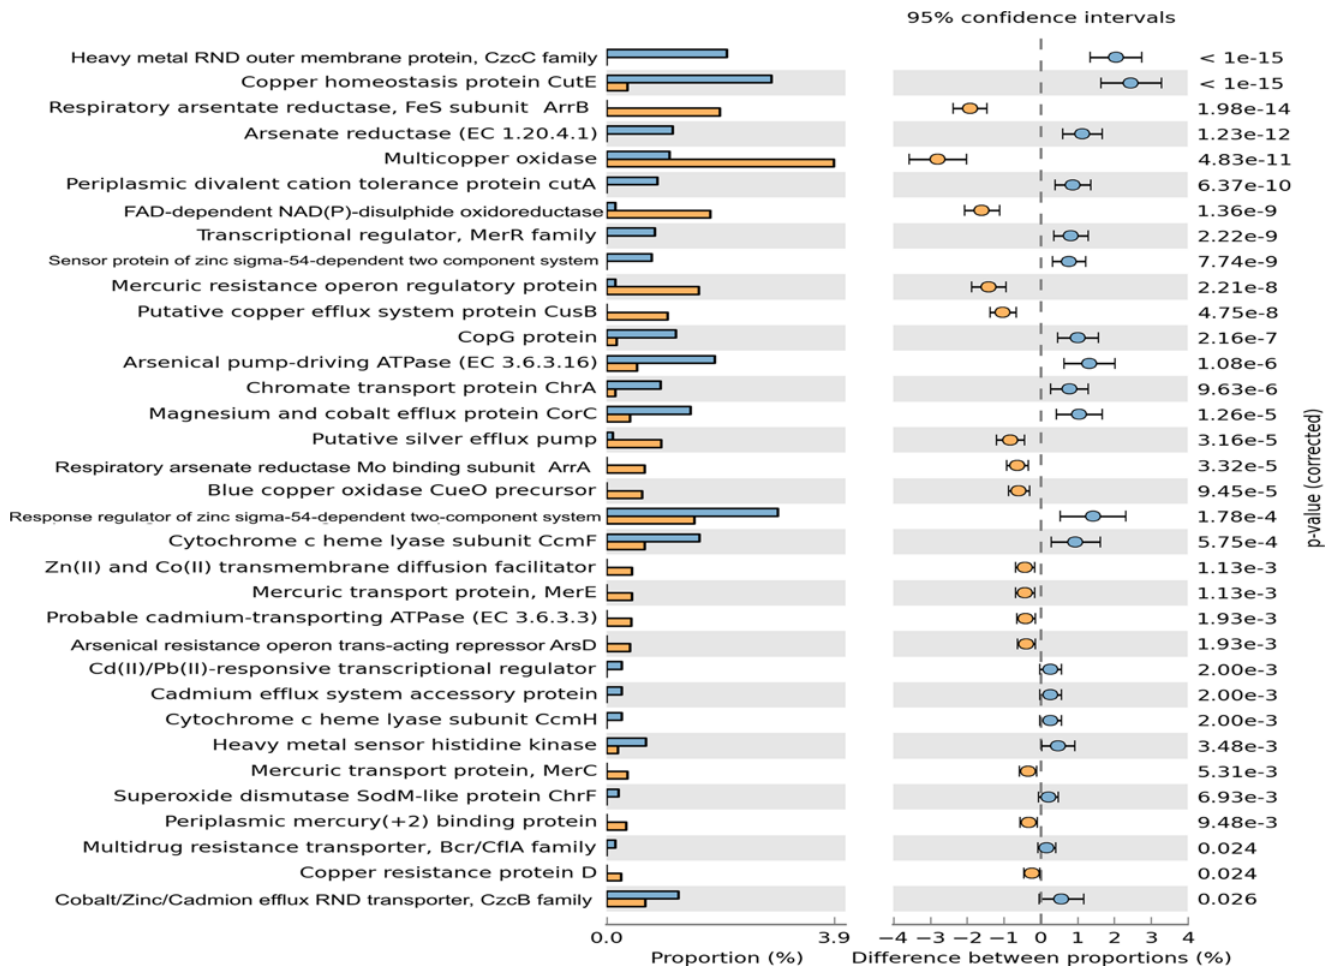
Fig 5. Significant metal resistance genes differences as a result of a Fisher exact test between the MSS and RAW metagenomes conducted with the STAMP program. Enrichment of metal resistance genes in the RAW metagenome has a positive difference between proportions (blue circles), whereas enrichment of metal resistance genes in the MSS metagenome has a negative difference between proportions (orange circles). Barson the left represent the proportion of each metal resistance protein in the data. Metal resistance difference with a p value of > 0.05 were considered to be